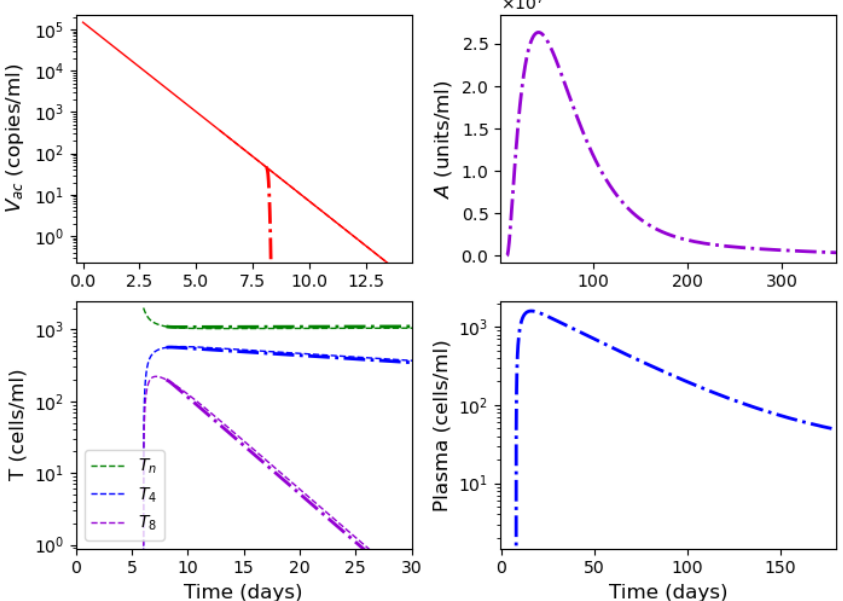
Figure 13. Numerical simulation of system (33)–(41) with virus concentration ( upper left ), antibodies ( upper right ), T cells ( lower left) and plasma cells ( lower right ). Adaptive immune response (dash- dot lines) starts on day 6 and antibody production from day 8. Note the difference in time scales (along the x-axes) in all